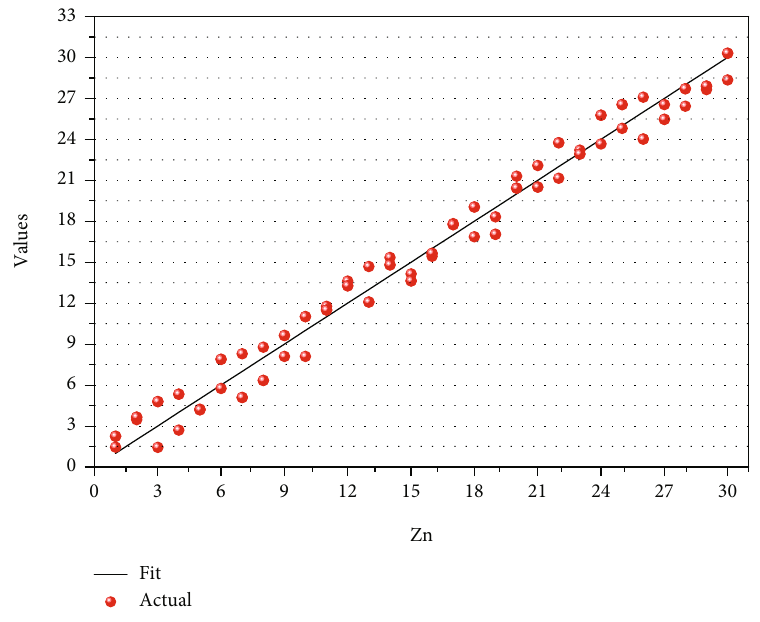
Figure 8: Search accuracy